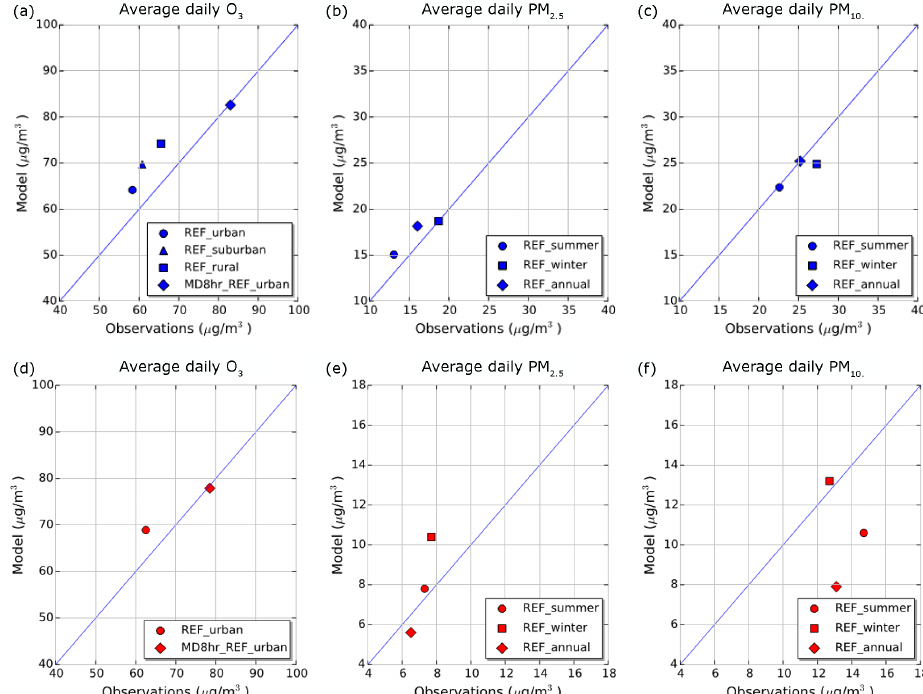
Figure 3. Ozone period (April–August) average ozone concentrations at urban, suburban and rural stations in IdF (a) and one urban station in the Stockholm area (d) . The MD8hr values at urban locations are also shown (MD8hr_REF_urban). Average PM 2 . 5 and PM 10 concentrations in wintertime (DJF), summertime (JJA) and on annual basis over urban stations in IdF are shown in (b, c) ( e, f for Stockholm).